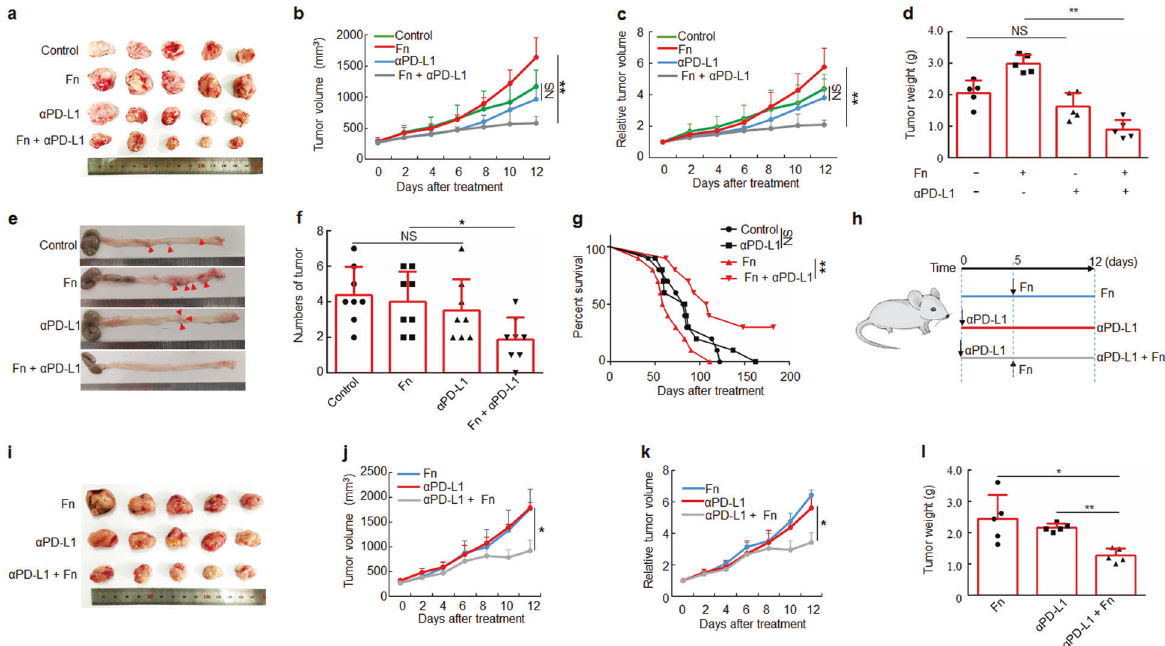
Fig. 2 F. nucleatum treatment augments the antitumor effects of PD-L1 blockade on CRC. a – d CT26.WT cells were subcutaneously injected into BALB/c mice. Tumor-bearing mice were intratumorally injected with PBS (control) or F. nucleatum and intraperitoneally injected treated with an anti-PD-L1 mAb or an isotype control mAb. a CT26.WT tumors from BALB/c mice in different groups at the end of the experiment are shown. Growth curves display tumor volumes b and relative tumor volumes c over time and the bar graph shows tumor weights at the end of the experiment d (One-way analysis of variance [ANOVA] and Bonferroni ’ s multiple comparison test). e Representative image of a colon of AOM/DSS-treated C57BL/6 mice with or without F nucleatum treatment and PD-L1 blockade. f The tumor numbers (diameter > 1 mm) of the different groups ( n = 8 per group, One-way ANOVA and Bonferroni ’ s multiple comparison test). g Survival curves of AOM/DSS-treated C57BL/6 mice receiving different treatments ( n = 10 per group) with Log-rank test. h Tumor-bearing mice were fi rst injected intraperitoneally with